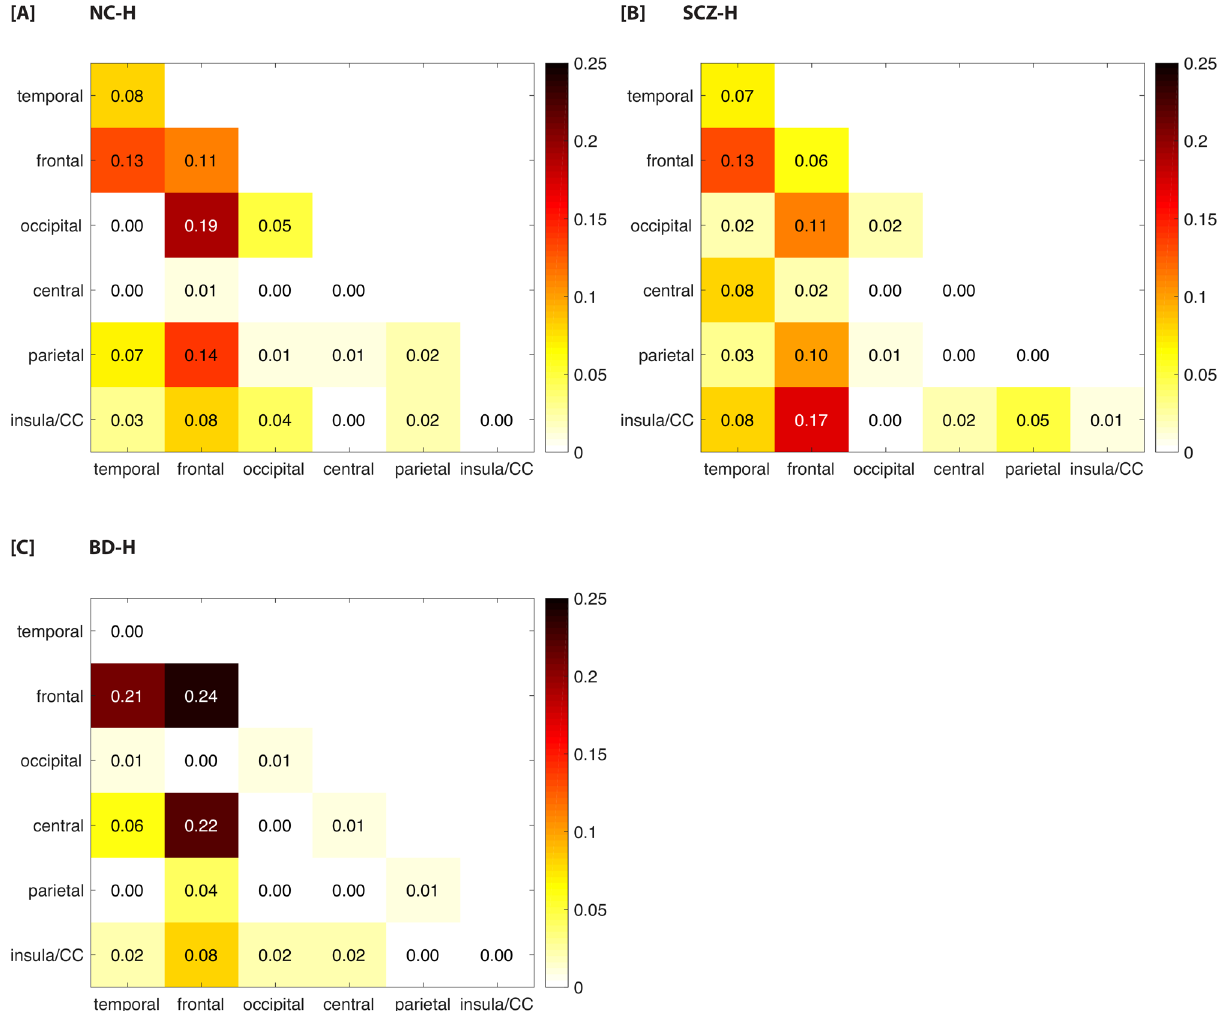
(n = 228); ( c ) bipolar-I disorder patients with lifetime history of hallucinations (n = 74) vs healthy controls (n = 228). Note that the hippocampus and amygdala are assigned to the temporal lobe. The putamen, pallidum and caudate are included in the central lobe. BD bipolar-I disorder without lifetime history of hallucinations, BD-H bipolar-I disorder with lifetime history of hallucinations, CC cingulate cortex, NC-H